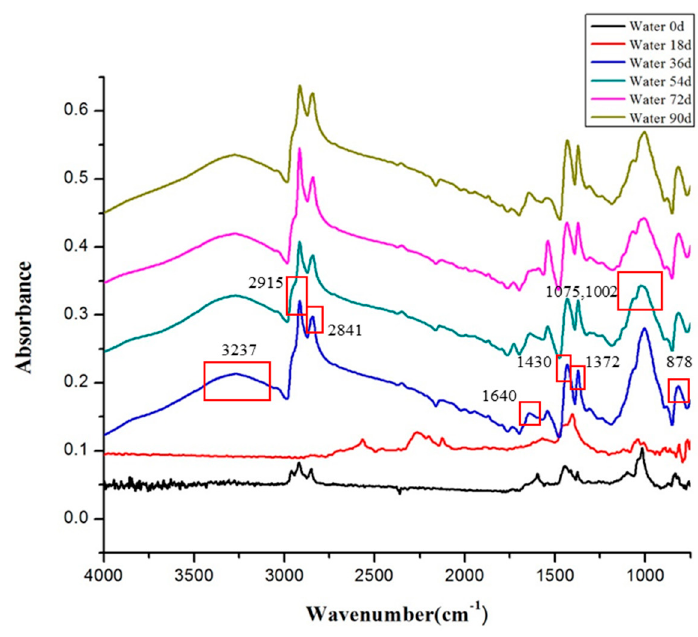
Figure 11. Infrared spectra of low-temperature water environment.